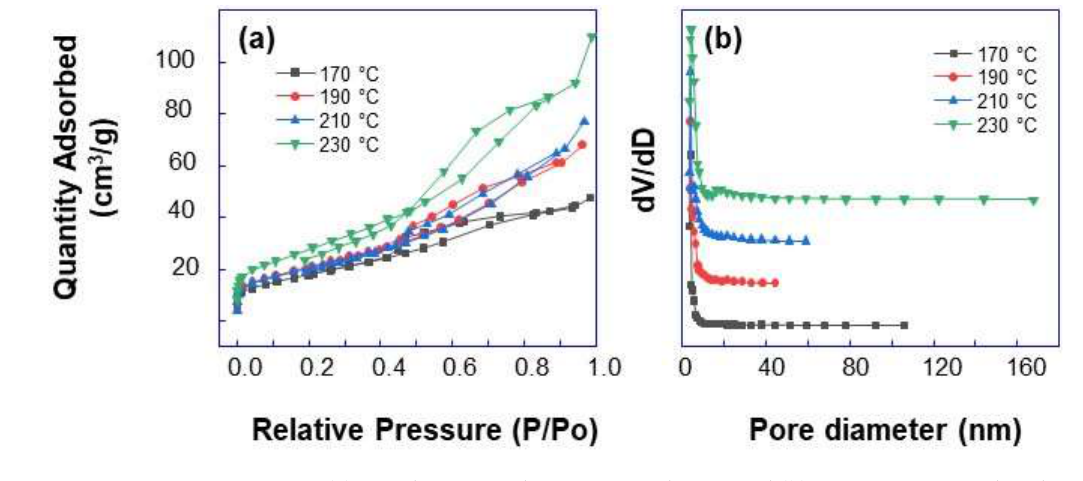
Figure 3. ( a ) N 2 adsorption–desorption isotherms and ( b ) GCMC pore size distribution curves for the TiO 2 powders prepared at various synthesis temperatures. Table 2. BET-specific surface area, mean pore diameter, and pore volume of the TiO 2 powders.